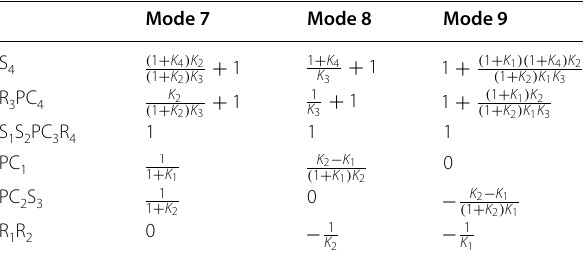
Table 4 Rotational speed of each component when